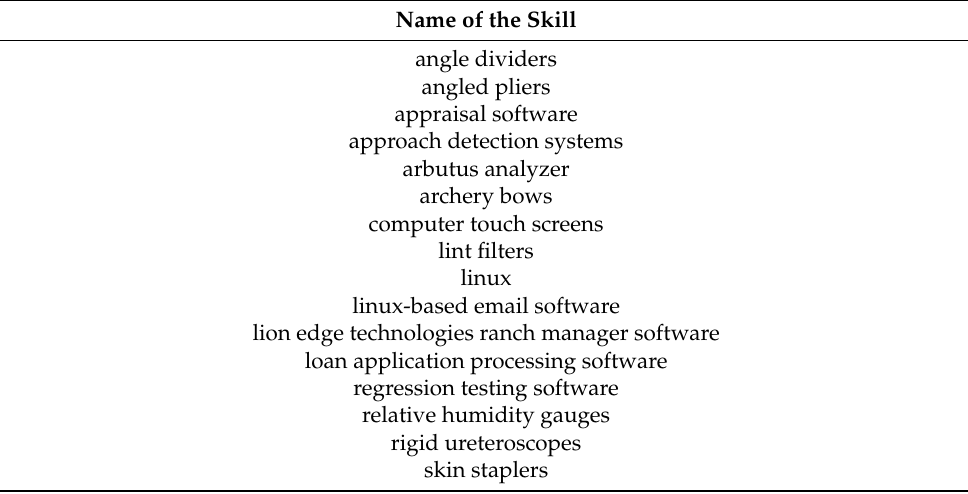
Table 7. Examples of skills in the Open Skills database.